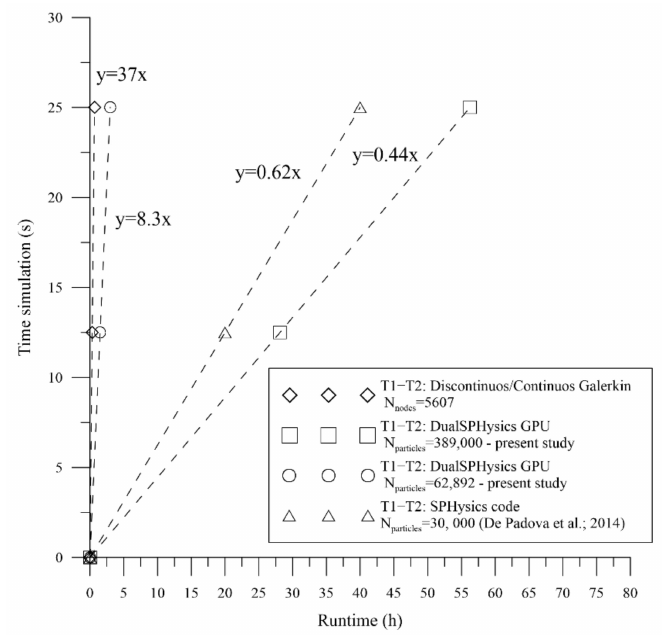
Figure 9. Comparison of runtime in T1 and